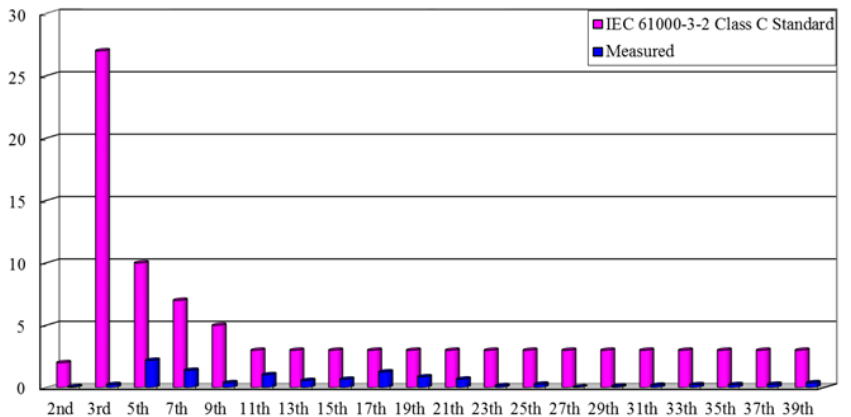
Figure 21. Measured harmonics of the input utility-line current in comparison with the IEC 61000-3-2 class C standard.